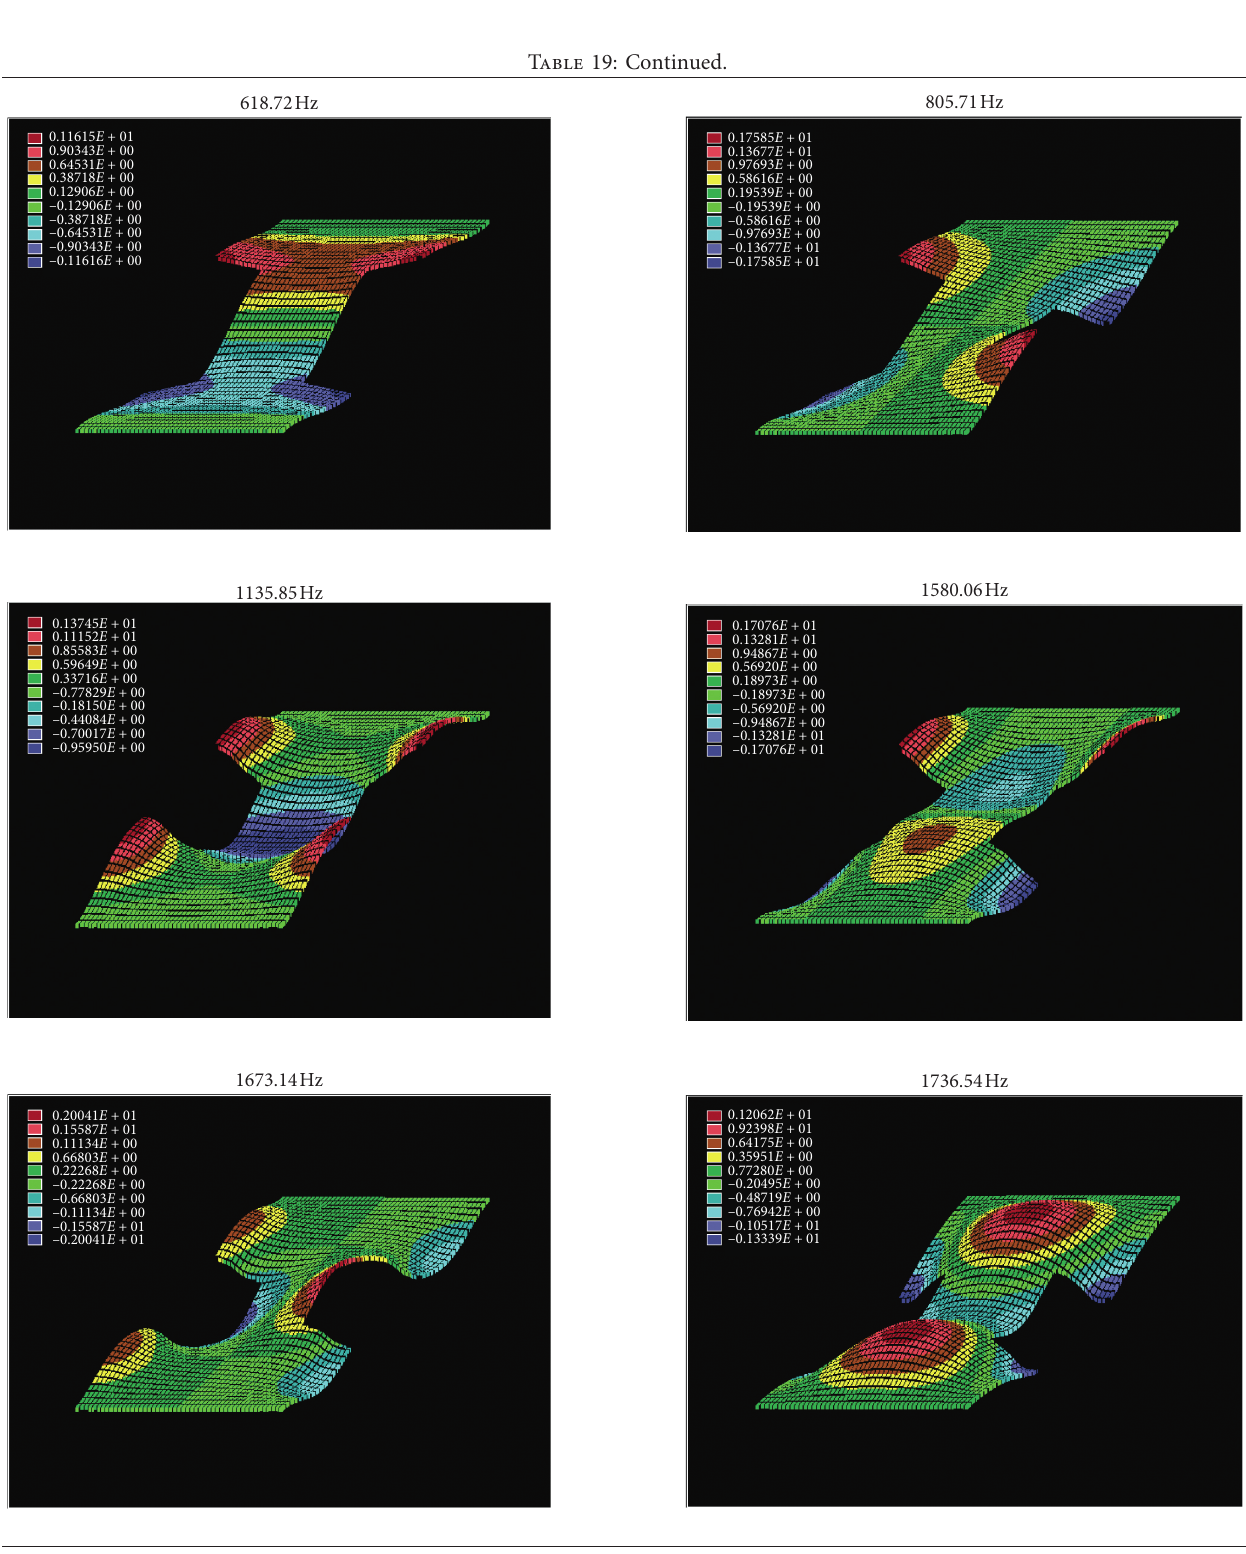
the lowest and higher modes, the frequency of the first mode has a difference value more than 30% that exceeds an acceptable value, the second mode halved the percental difference with respect to the experimental analysis, and